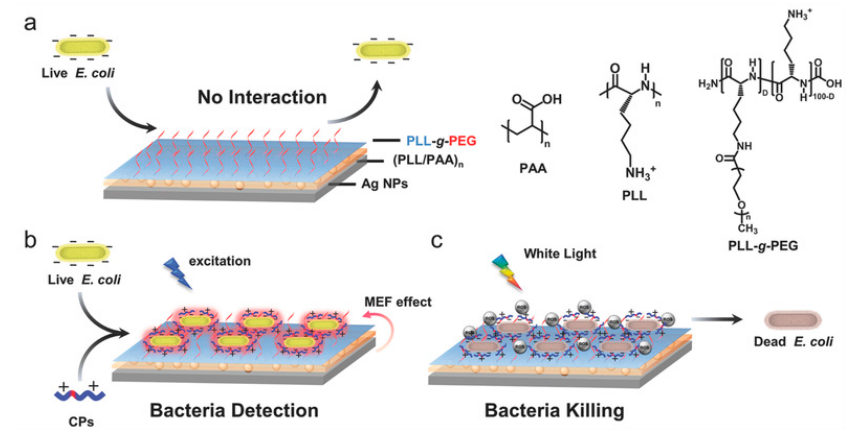
Figure 17. ( a ) Example of multifunctional bioassay for detection and disinfection using adsorbed PLL-g-PEG brushes for preventing adsorption of proteins and bacteria ( b ) Operational principle for capture and detection of E. coli by fluorescently measuring the response of CP coupled with the plasmon-enhance fluorescence from the Ag nanostructure ( c ) Disinfection is achieved from reactive oxygen species produced by CP under white light irradiation (adapted with permission from [18]).